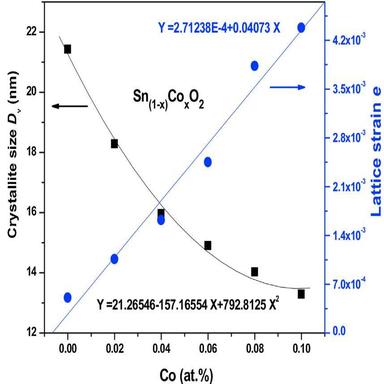
Dependence of the crystallite size D and strain e formed in SnO2 nanoparticles on Co doping concentrations.